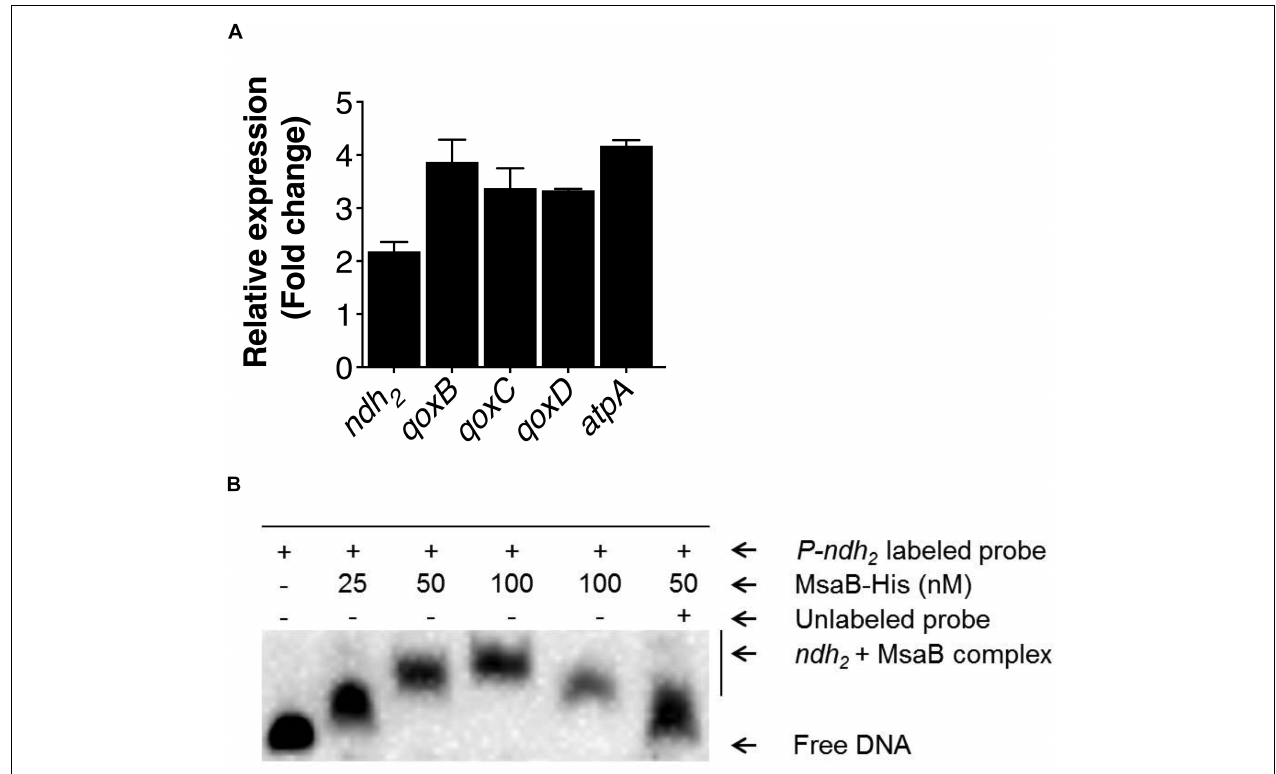
FIGURE 6 | Measurement of electron transport chain (ETC) gene expression and regulation of ndh 2 . (A) Expression of ETC genes as well as gudB was measured by qRT-PCR of RNA samples isolated from cells grown overnight in chemically defined medium (CDM). The bar graph shows the fold change in expression of genes in the (cid:77) msaABCR compared with the isogenic USA300 LAC strain. (B) EMSA shows MsaB binding to the promoter of ndh 2 . Increasing concentrations of MsaB were incubated with appropriate concentrations of ssDNA from the region upstream of the transcription initiation site for ndh 2 . The band shift was reduced in a competition assay with a 100-fold greater concentration of unlabeled ndh 2